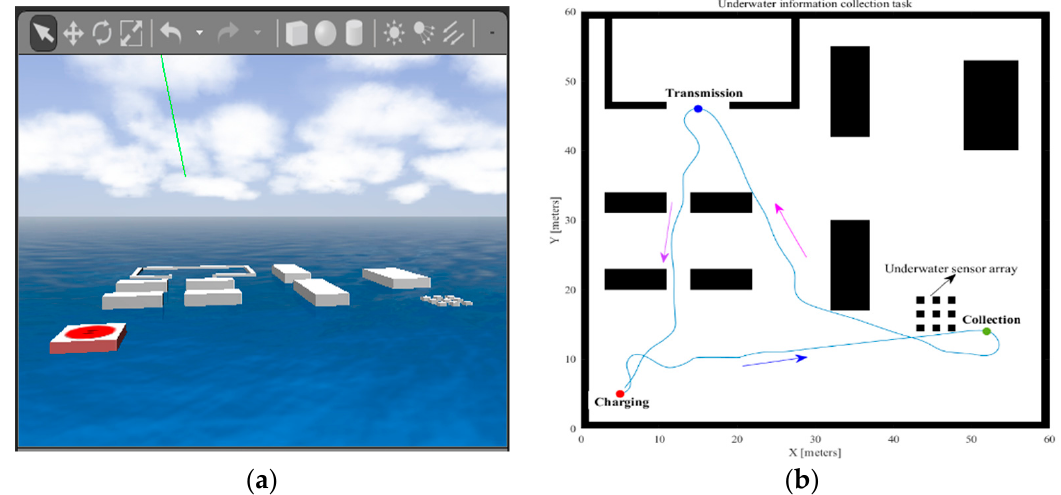
Figure 10. The simulation results of scheduling task. ( a ) Simulation scenario for task scheduling. ( b ) The trajectory of the UUV in the simulation platform.